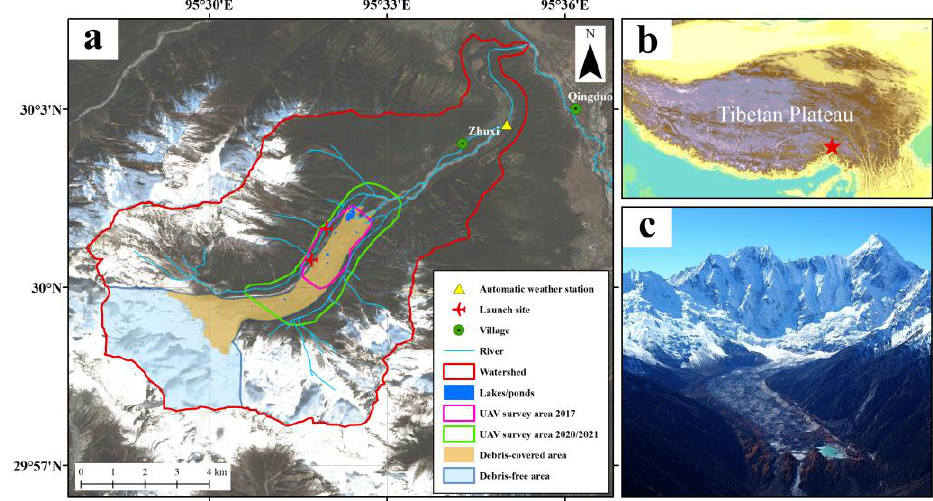
Figure 1. ( a , b ) The location of Zhuxi Glacier with the extent of the UAV survey in 2017 and 2020/2021, the distribution of debris-covered and debris-free areas, and supraglacial ponds, as well as the rivers, contours, watershed, and villages nearby. The background image in ( a ) is a Planet 4-band image acquired in 2020. ( c ) The panorama photo taken in 2020.